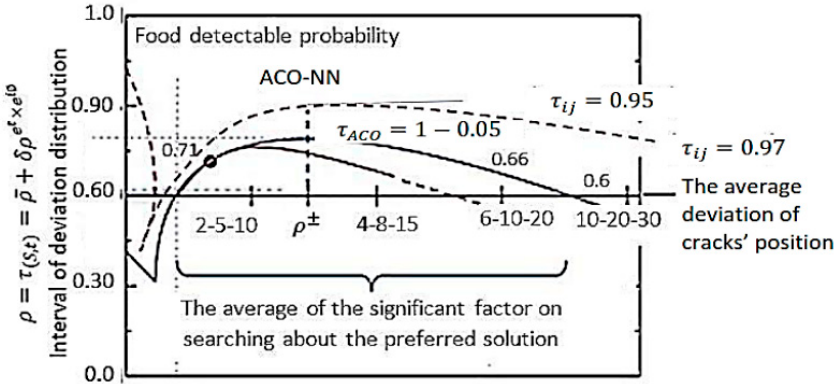
Figure 17. The predictable 𝜌 of pheromone in equations 19 and 20.